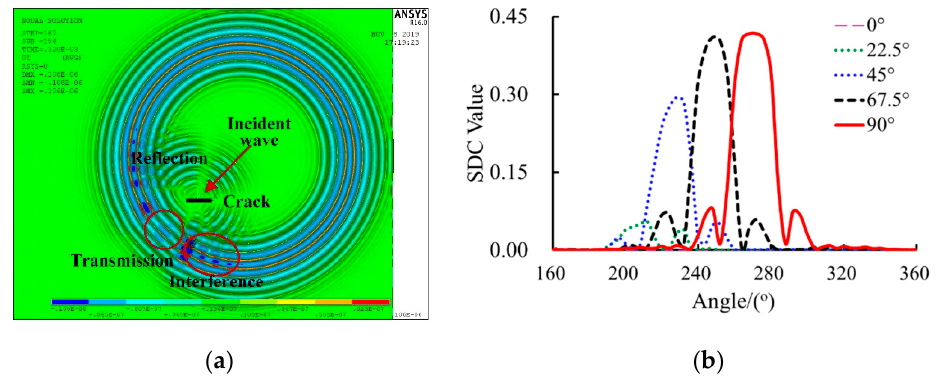
Figure 8. FEA results and signal difference coefficient (SDC) distributions: ( a ) displacement magnitude at oblique incidence (45°) and ( b ) SDC distributions with different incident wave directions.